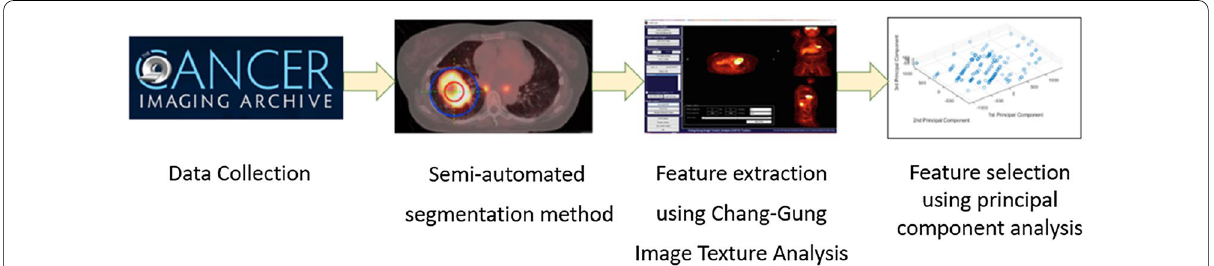
Fig. 4 Adenocarcinoma in non-small cell lung cancer (NSCLC) detection using radiomics [167]